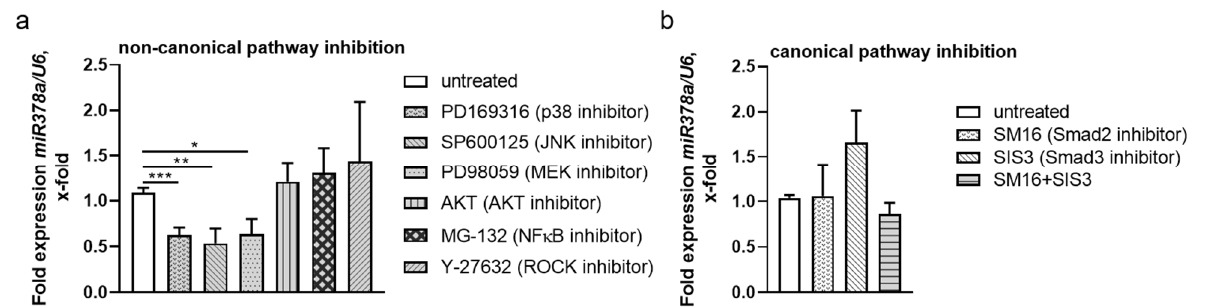
Figure 6. Post-transcriptional regulation of NPNT expression might be mediated by miR-378a-3p. ( a , b ): TaqMan PCR for miR-378a-3p detection in cultured human podocytes after treatment with inhibitors of the ( a ): non-canonical pathways (PD169316, SP600125, PD98059, AKT inhibitor, MG- 132, and Y-27632) and ( b ): canonical pathway inhibitors (SM16 and SIS3), plotted as the change as compared to untreated cells. n = 4–6 independent experiments. * p < 0.05, ** p < 0.01 *** p < 0.001.